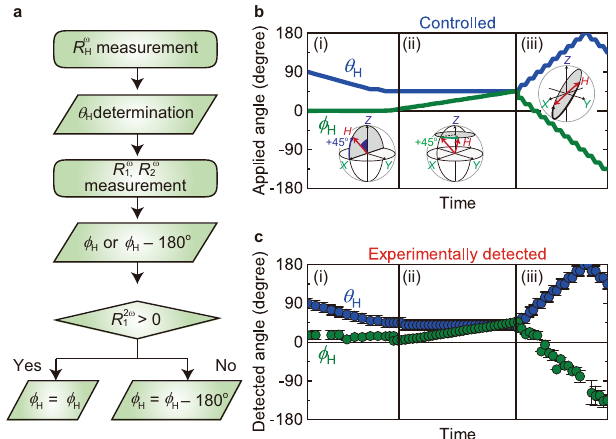
Fig. 4 Demonstration of detection of the magnetic fi eld vector. a Flow chart for determination of the magnetic- fi eld vector by the Fe – Sn magnetometer. The polar angle θ H is determined by R ω through AHE H whereas the azimuthal angle ϕ is determined by R ω , R ω , and the sign of R 2 ω 1 2 1 H through AMR and UMR, respectively. b Time evolution of θ H (blue) and ϕ H (green) of the controlled magnetic fi eld H . Schematics for the rotation of H vector is depicted in insets. c Experimentally detected θ H and ϕ by the H Fe – Sn device. The error bar of θ H and ϕ H was de fi ned by the contribution of AMR to R ω and the difference in detected angles by R ω and R ω , H 1 2